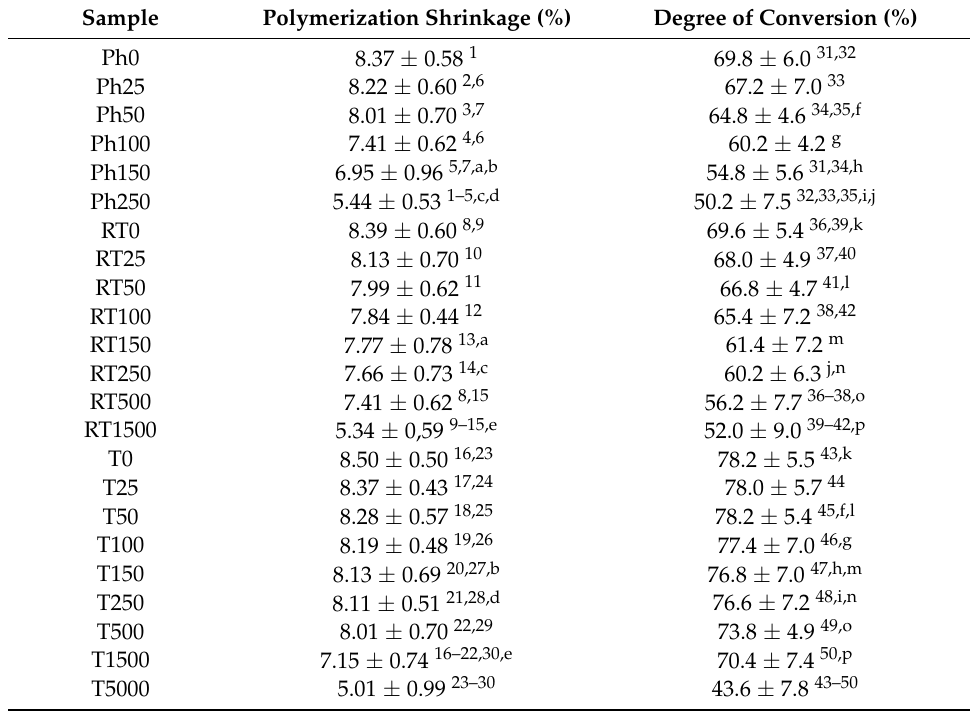
Table 3. The polymerization shrinkage and degree of conversion in studied Bis-GMA/TEGDMA/ AgNP